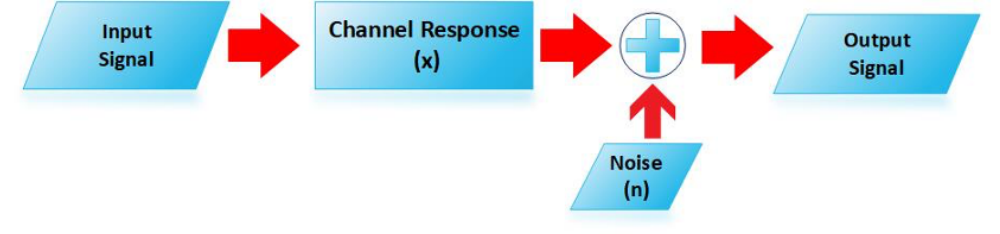
Figure 4. Desired signal, interference from other cell and noise added to the signal during